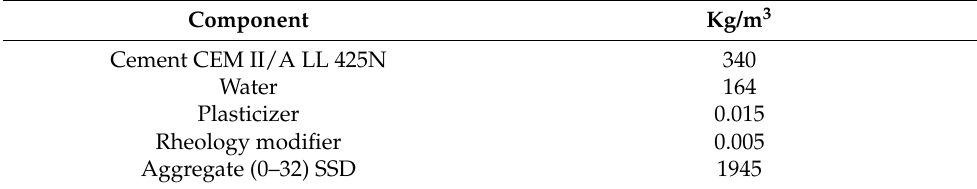
Table 2. Component in OC-C30/37.